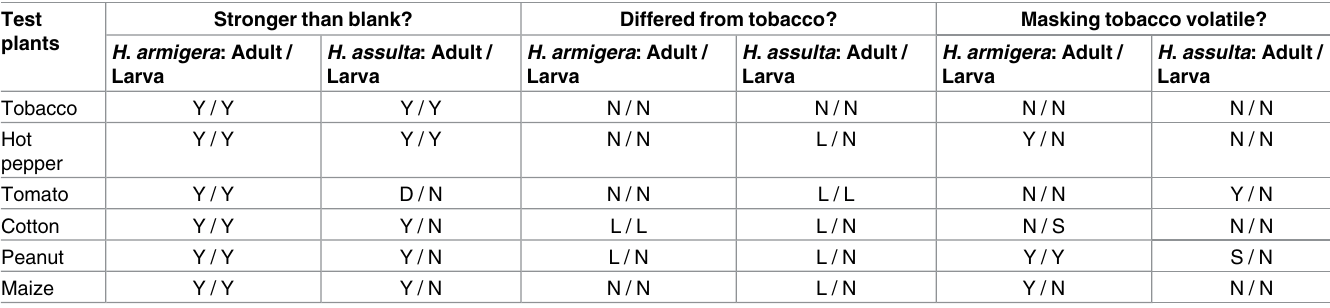
Table 1. Comprehensive comparison: species, stages, and